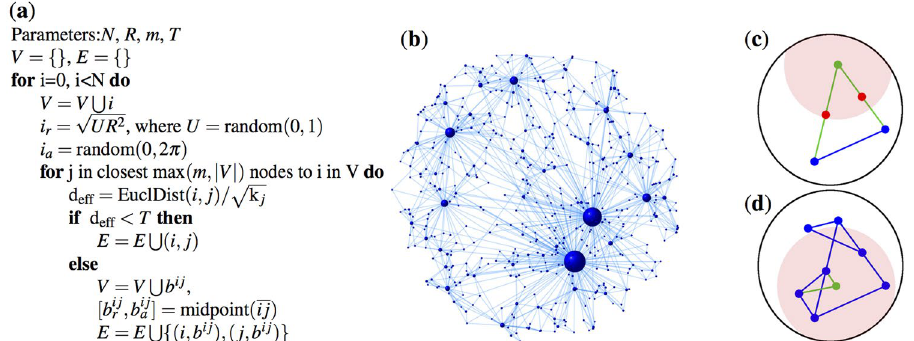
Figure 2. Details of the model. Panel (a) shows the exact pseudocode of the generation process. Panel (b) plots a sample network generated by the model. Panels (c,d) shows the time evolution of the network for m = 2. In panel (c) a green node is added to a network consisting the two blue nodes only. The red circle represents the threshold around the new node. As neither of the two blue points reside within the red circle two bridge nodes (red) are inserted to the midpoints of the edges. Panel (d) shows the same network in a later time instant. In this later phase the new green node can connect directly (bridge nodes are not needed) to the two nearest blue nodes as they are closer than T